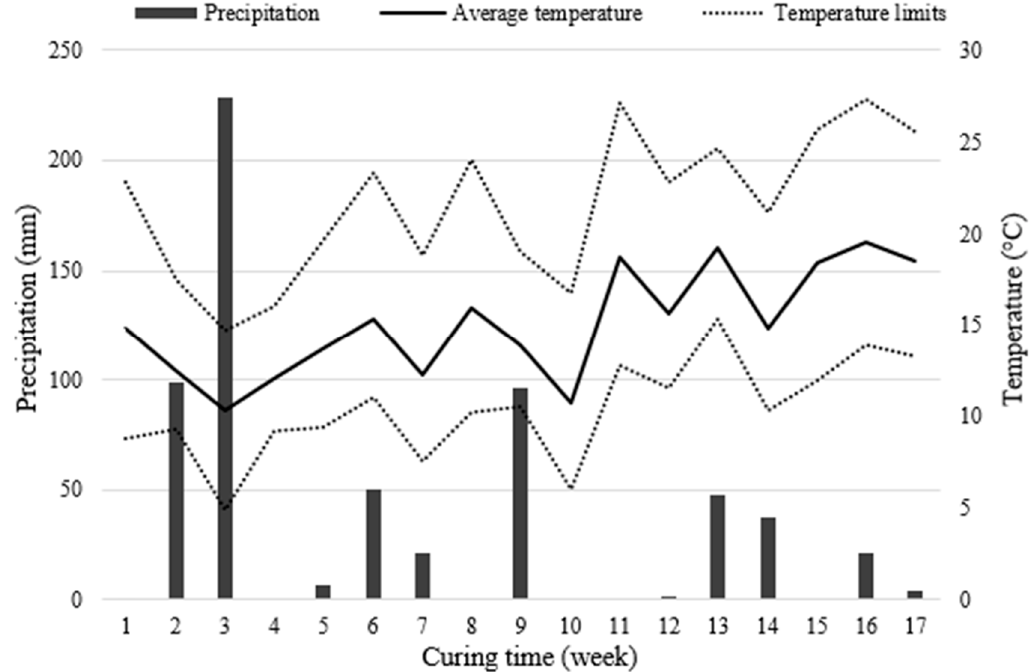
Figure 10. Precipitation and temperature during the curing period.